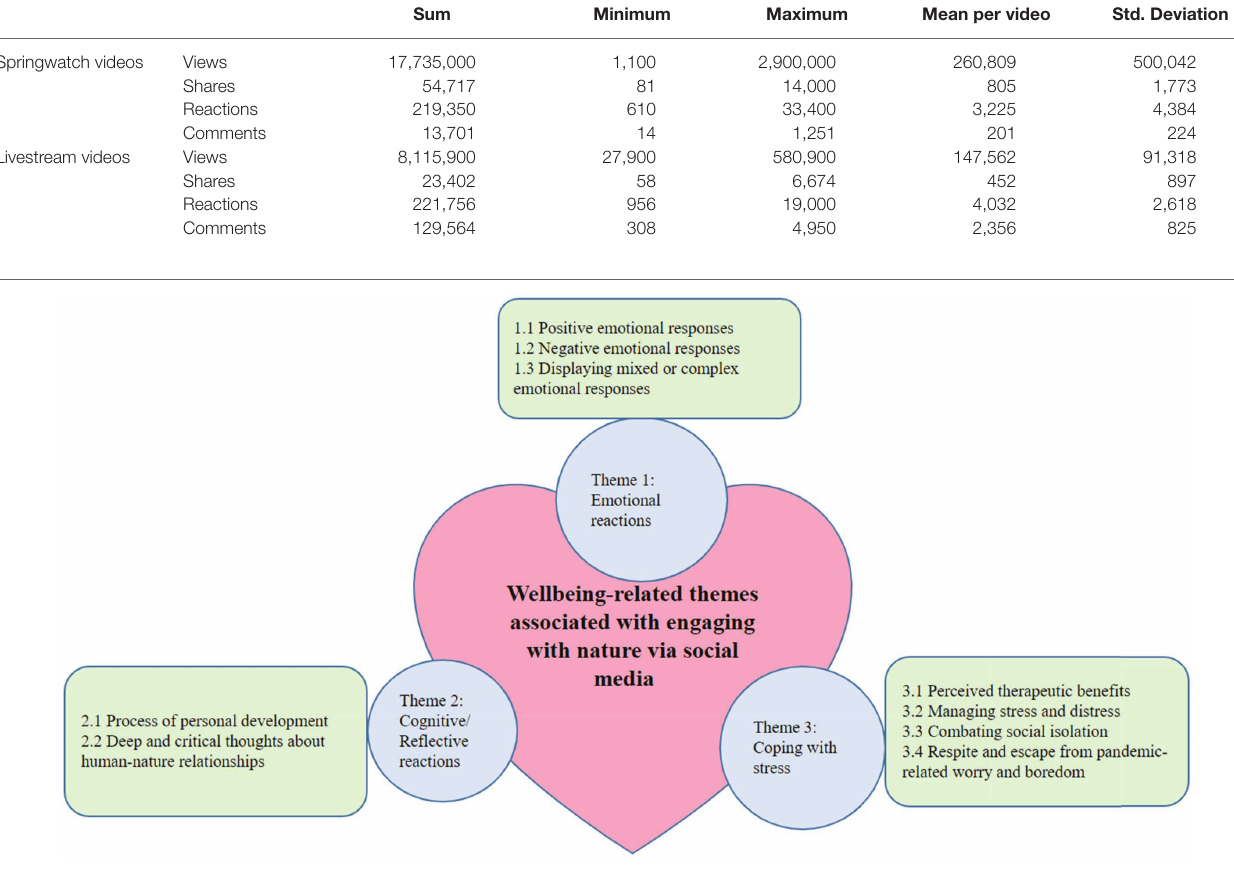
TABLE 1 | Descriptive statistics for the online engagement with the 68 and 55 videos examined in the Springwatch and livestream videos, respectively. Sum Minimum Maximum Mean per video Std. Deviation